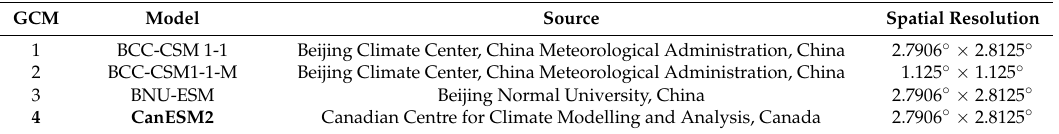
Table 1. Information of selected 23 general circulation models (GCMs) from Phase 5 of the Coupled Model Intercomparison Project